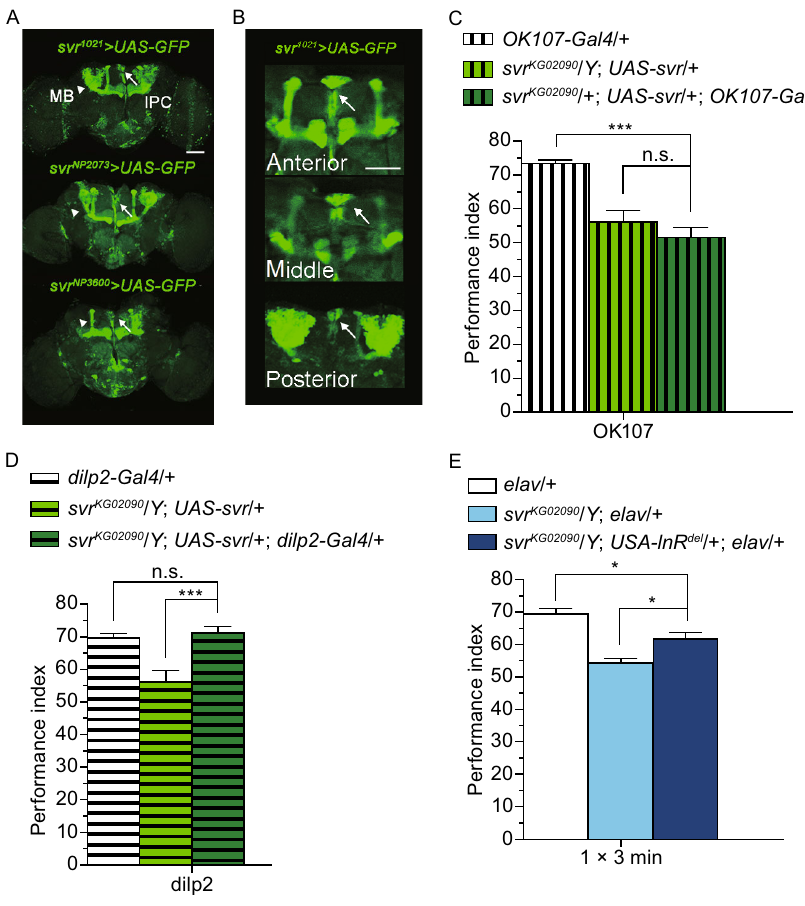
Figure 2. Restricted expression of svr + in the insulin-producing cells is suf fi cient to rescue the svr memory formation defect and insulin signaling is involved in svr regulated memory formation . (A) The confocal imaging of three types of svr-Gal4 driven GFP expression in the adult brain revealed preferential expression in the MB and clusters of median neurosecretory cells. Scale bar is 100 μ m. (B) Enlarged views of anterior, middle, and posterior section of svr 1021 -Gal4 driven GFP expression. Arrow indicates IPCs. Scale bar is 50 μ m. (C and D) Immediate memory defect in svr KG02090 mutant was rescued by inducing svr + transgene in IPCs ( dilp- Gal4 driven) (ANOVA, P = 0.0007 for svr KG02090 / Y ; UAS-svr /+; dilp2-Gal4 /+ compared to svr KG02090 / Y ; UAS-svr /+, P = 0.857 for svr KG02090 / Y ; UAS-svr /+; dilp2-Gal4 /+ compared to dilp2-Gal4 /+), but not by inducing svr + transgene in MB ( OK107-Gal4 driven) (ANOVA, P = 0.426 for svr KG02090 / Y ; UAS-svr /+; OK107-Gal4 /+ compared to svr KG02090 / Y ; UAS-svr /+, P < 0.0001 for svr KG02090 / Y ; UAS-svr /+; OK107-Gal4 /+ compared to OK107-Gal4 /+). n = 6 – 7. For the X chromosome-located svr mutant, only male fl ies results were shown. (E) Expressing constitutively active InR ( UAS-InR del ) in nervous system partially reversed the memory impairment in svr KG02090 (ANOVA, P = 0.016 for elav /+ compared to svr KG02090 / Y ; UAS-InR del /+; elav /+, P = 0.023 for svr KG02090 / Y ; elav /+ compared to svr KG02090 / Y ; UAS-InR del /+; elav /+). n = 6 – 7. Data are shown as the mean ± SEM. *P < 0.05; **P < 0.01; *** P <